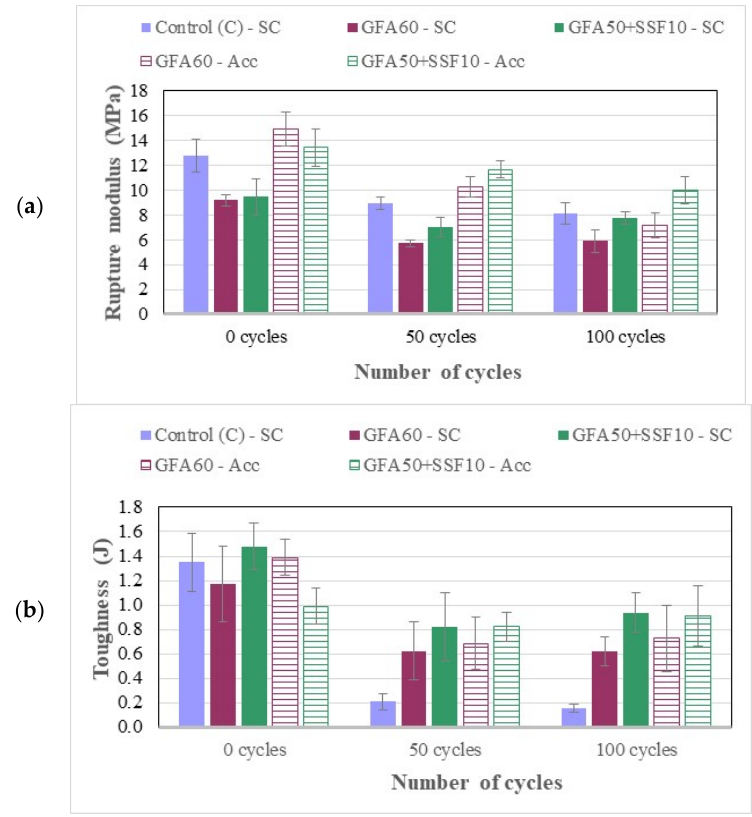
Figure 10. Modulus of rupture ( a ) and toughness ( b ) of the GRC composites subjected to freeze–thaw tests.